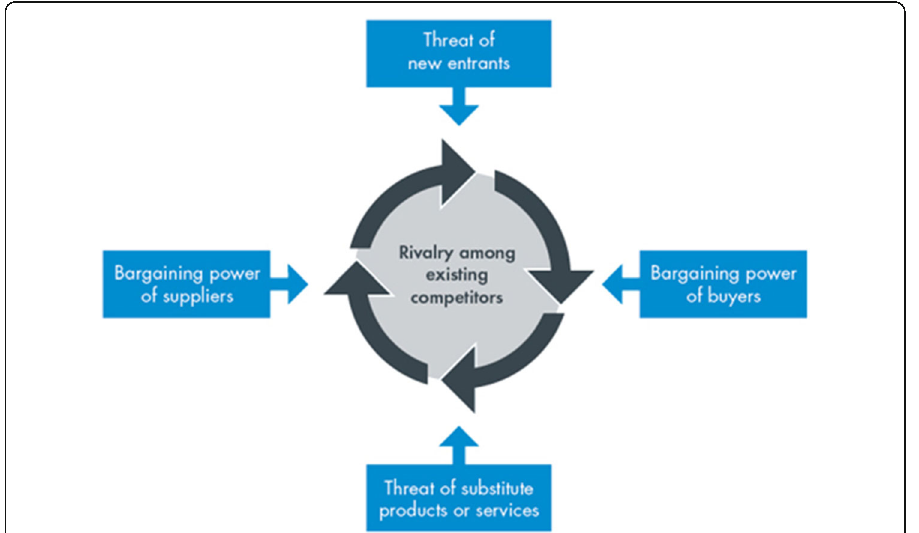
Fig. 5 Five forces of competition. Source (Baldegger et al.,